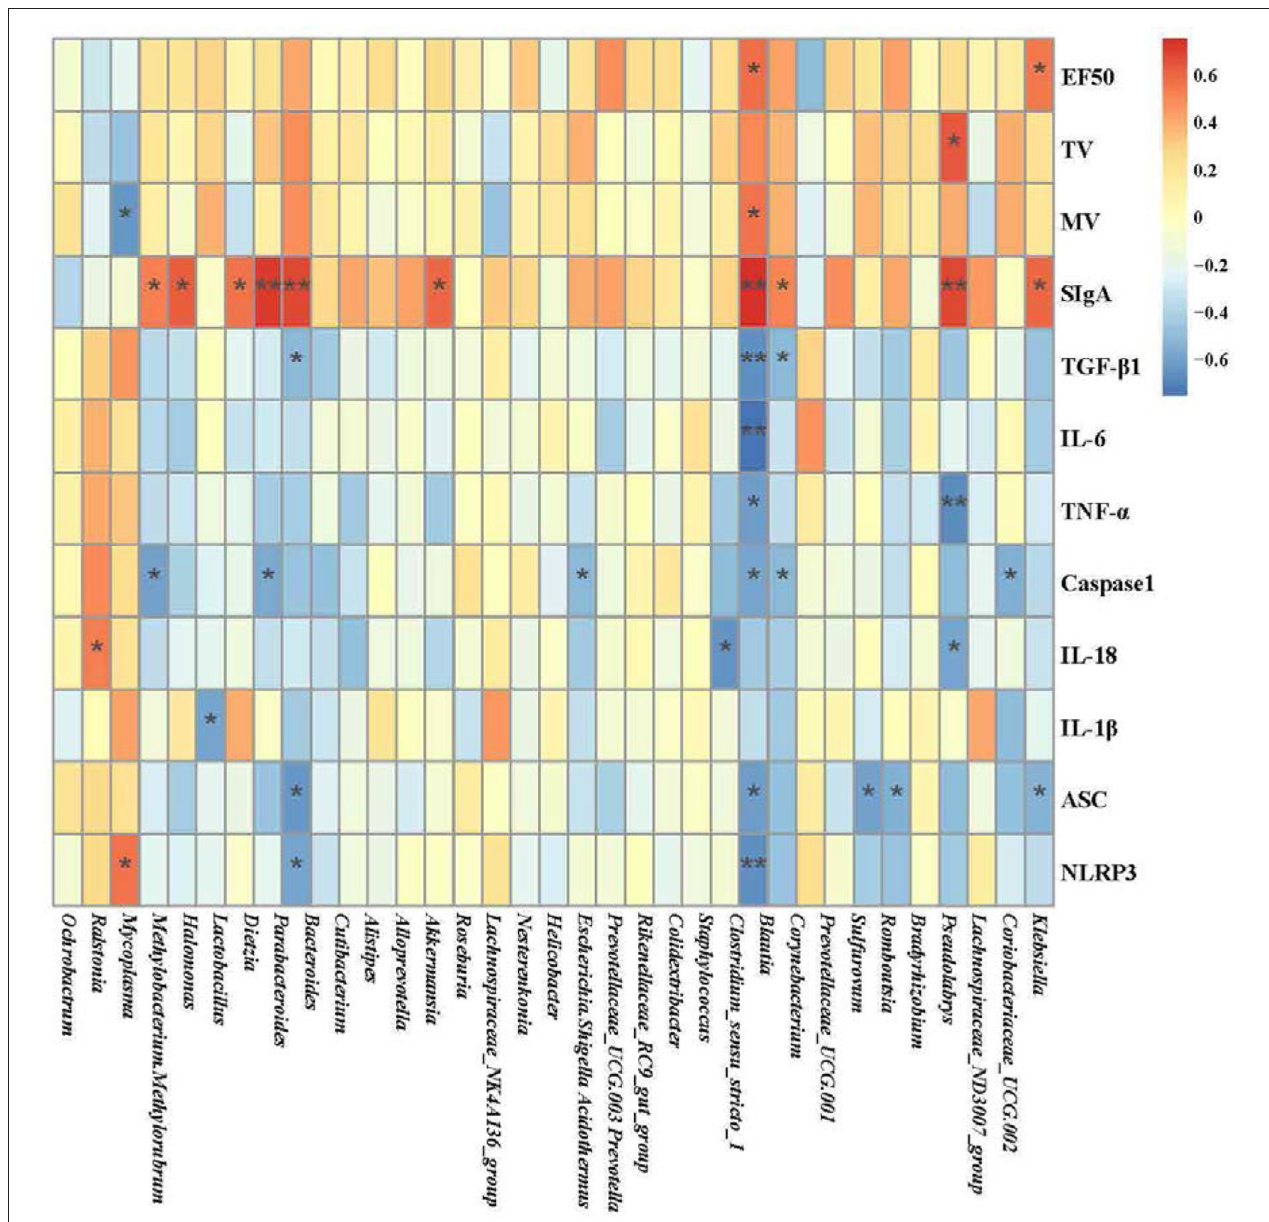
FIGURE 8 | Heatmap of the correlation among the pulmonary microbiota related to environmental factors (* P < 0.05, ** P < 0.01; blue represents a negative correlation; red represents a positive correlation). The analysis of pulmonary microbiota was performed using the online tool of NovoMagic at https://magic.novogene. com via a personal